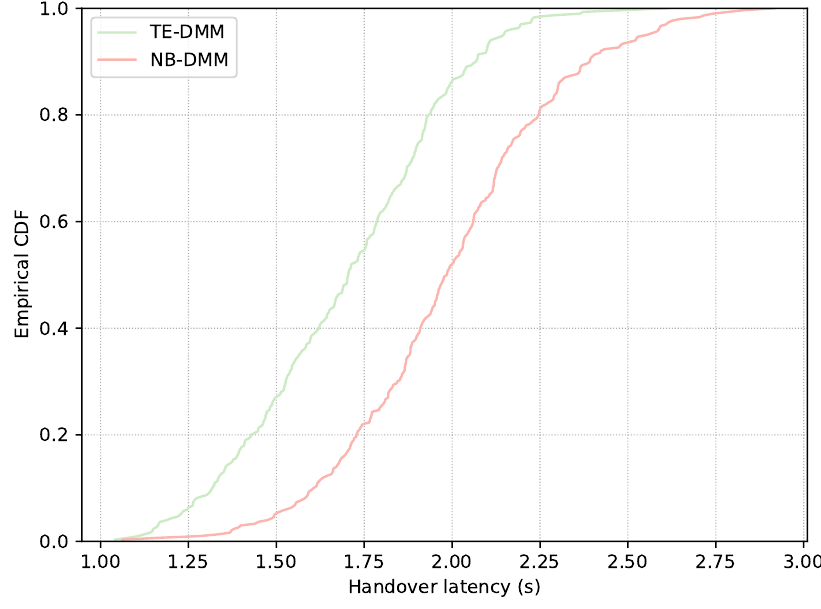
Figure 11. Empirical cumulative distribution function (CDF) of the handover measurements.